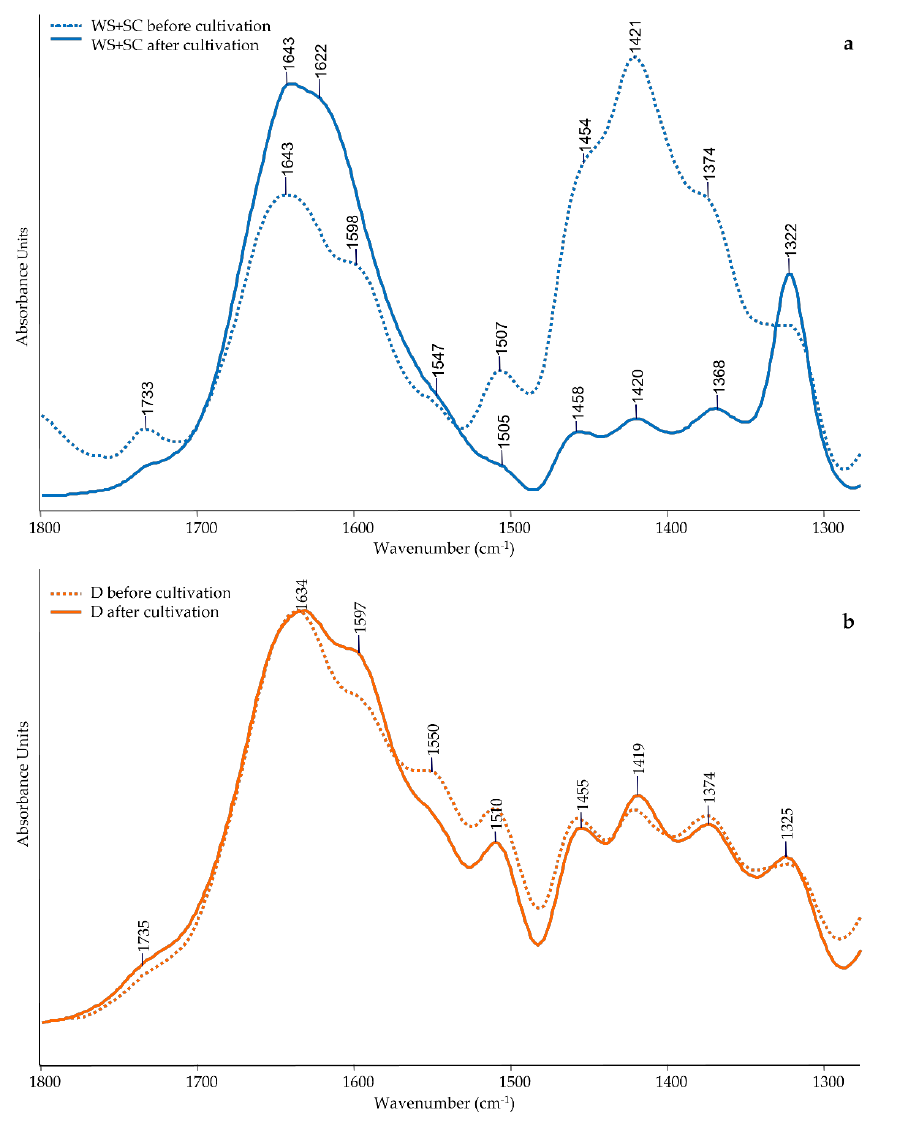
Figure 4. ATR-FTIR spectra (1800–1300 cm − 1 ) of WS + SC ( a ) and D ( b ) before the mycelial growth (dotted line) a nd after P. ostreatus mycelial growth (solid line). (dotted line) and after P. ostreatus mycelial growth (solid line).